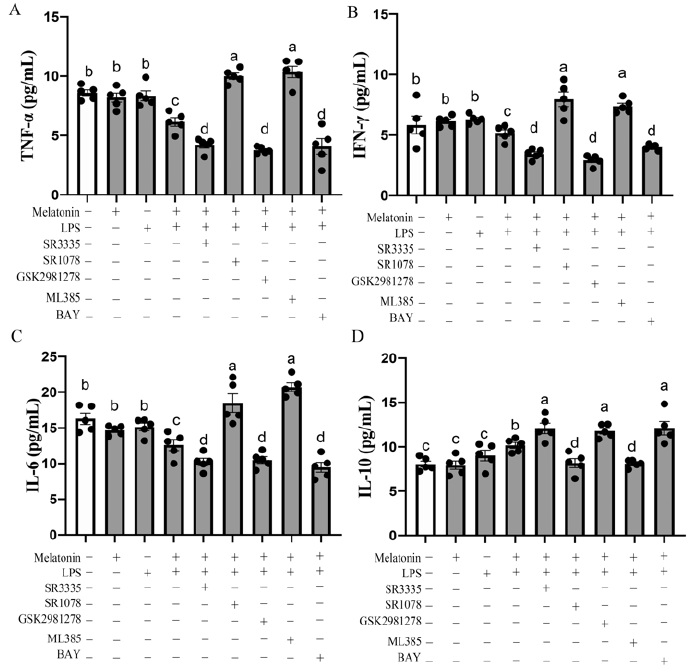
Figure 7. Effects of ROR α antagonists, ROR α agonist, ROR γ antagonist, Nrf2 antagonists and p65 antagonists on pro ‐ inflammatory cytokine TNF ‐α ( A ), IFN ‐γ ( B ), IL ‐ 6 ( C ), anti ‐ inflammatory cyto ‐ kine IL ‐ 10 ( D ) level of bursal B ‐ lymphocyte in response to LPS in the G → B group. SR3335 is a ROR α antagonist; SR1078 is a ROR α agonist; GSK1981278 is a ROR γ antagonist; ML385 is an NRF2 antag ‐ onist; BAY is a p65 antagonist. Differences between seven light treatment groups were evaluated by one ‐ way ANOVA, and values with no common letters differ significantly ( p < 0.05).